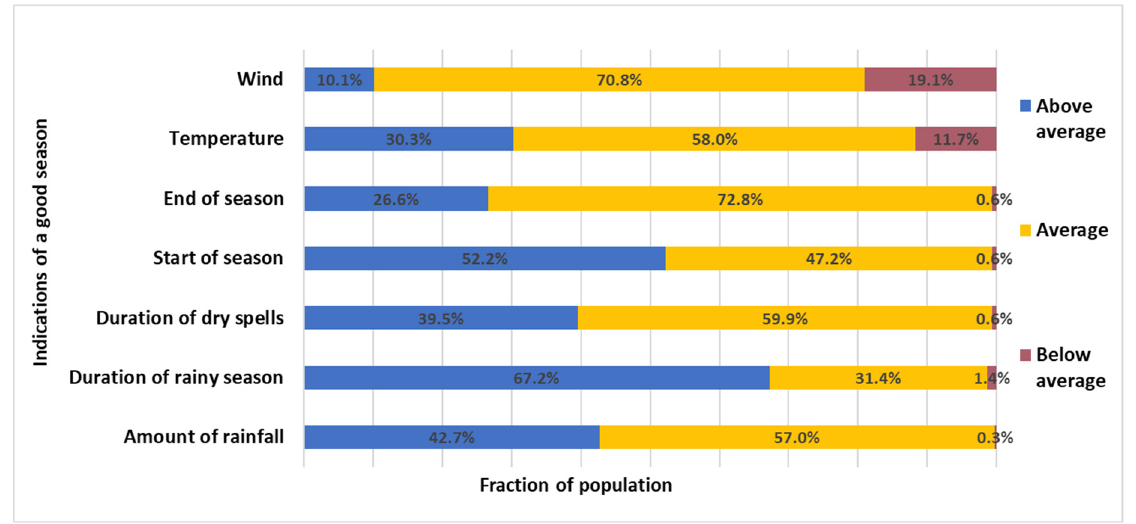
Figure 8. Community indicators of a good season (year): brown is above average, yellow is average, and blue is below average. Table 4. Strategies to be implemented for good agropastoral season perspectives.